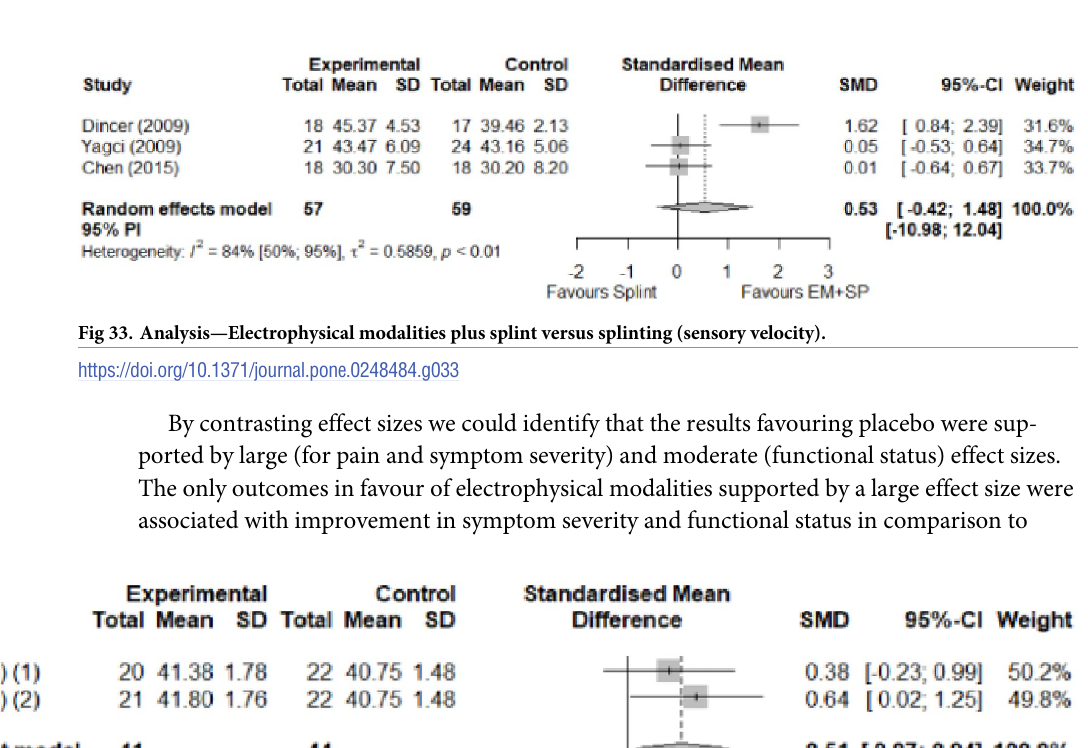
Fig 32. Analysis—Electrophysical modalities alone versus splinting (motor latency). Studies with more than two intervention groups (different modalities) were numbered as (1) and (2).